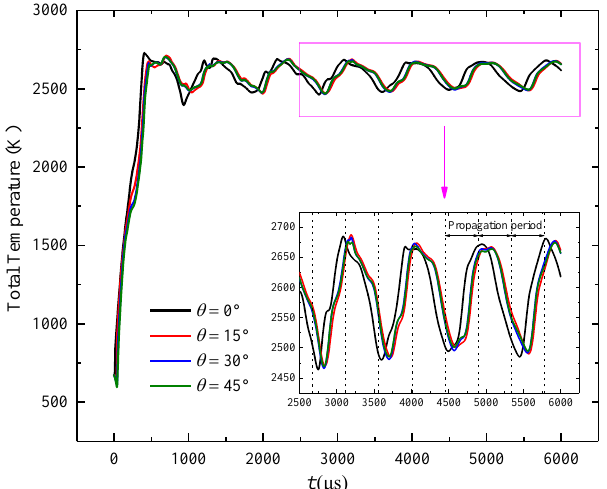
Figure 17. The time-varied outlet total temperature of the RDC with different θ .